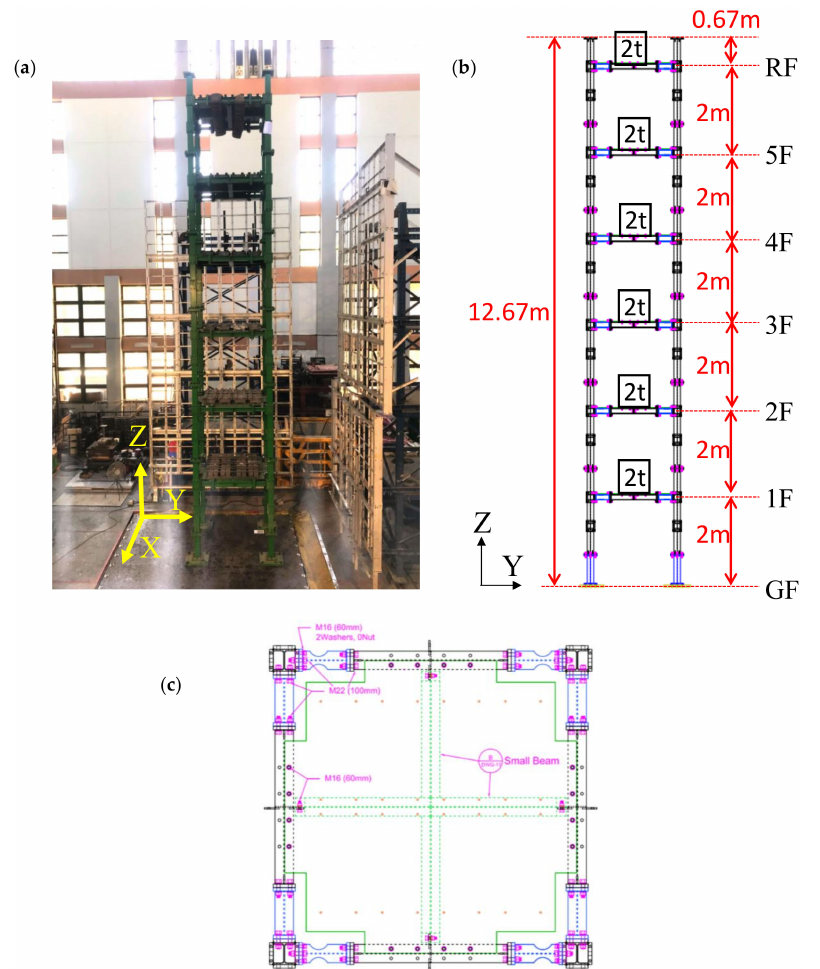
Figure 8. The scaled six-story steel building specimen: ( a ) overview; ( b ) elevation view; ( c ) plan view of first floor with weaker cross section of the beams along the